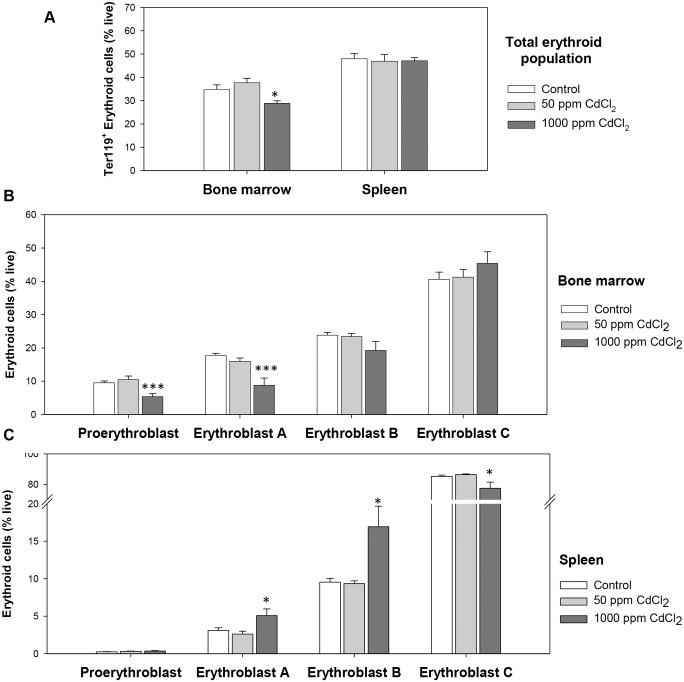
Erythroid population in bone marrow and spleen.Mice were given cadmium chloride dissolved in drinking water (50 ppm and 1000 ppm). Mice were sacrificed and their bone marrow and spleen cells were harvested. Isolated cells were double stained with anti-mouse CD71-PE and anti-mouse Ter119-APC and proportion of cells in different stages of erythropoiesis were determined. Four distinct stages of erythroid differentiation could be identified within an inverted ‘L’ shaped gate in the flow diagram. These include early proerythroblasts (CD71highTer119med), early basophilic erythroblast or erythroblasts A (Ter119highCD71highFSChigh), late basophilic polychromatic and orthochromatic erythroblasts or erythroblasts B (Ter119highCD71highFSClow), and orthochromatic erythroblasts or erythroblasts C (Ter119highCD71lowFSClow). Total erythroid population (panel A), and erythroid cells in different maturational stages in bone marrow (panel B) and spleen (panel C) after 5 weeks of cadmium exposure have been shown above. Each bar in the graph represents mean ± SEM of observations on 5–6 mice. *p<0.05 and ***p<0.005 for comparison of the groups (Student t-test).